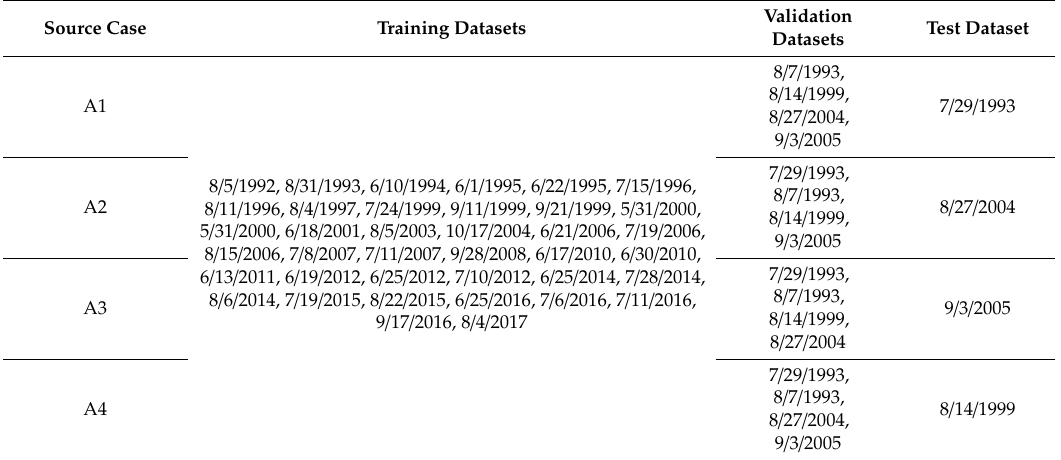
Table 4. Source datasets for training, validation, and testing in Domain A.